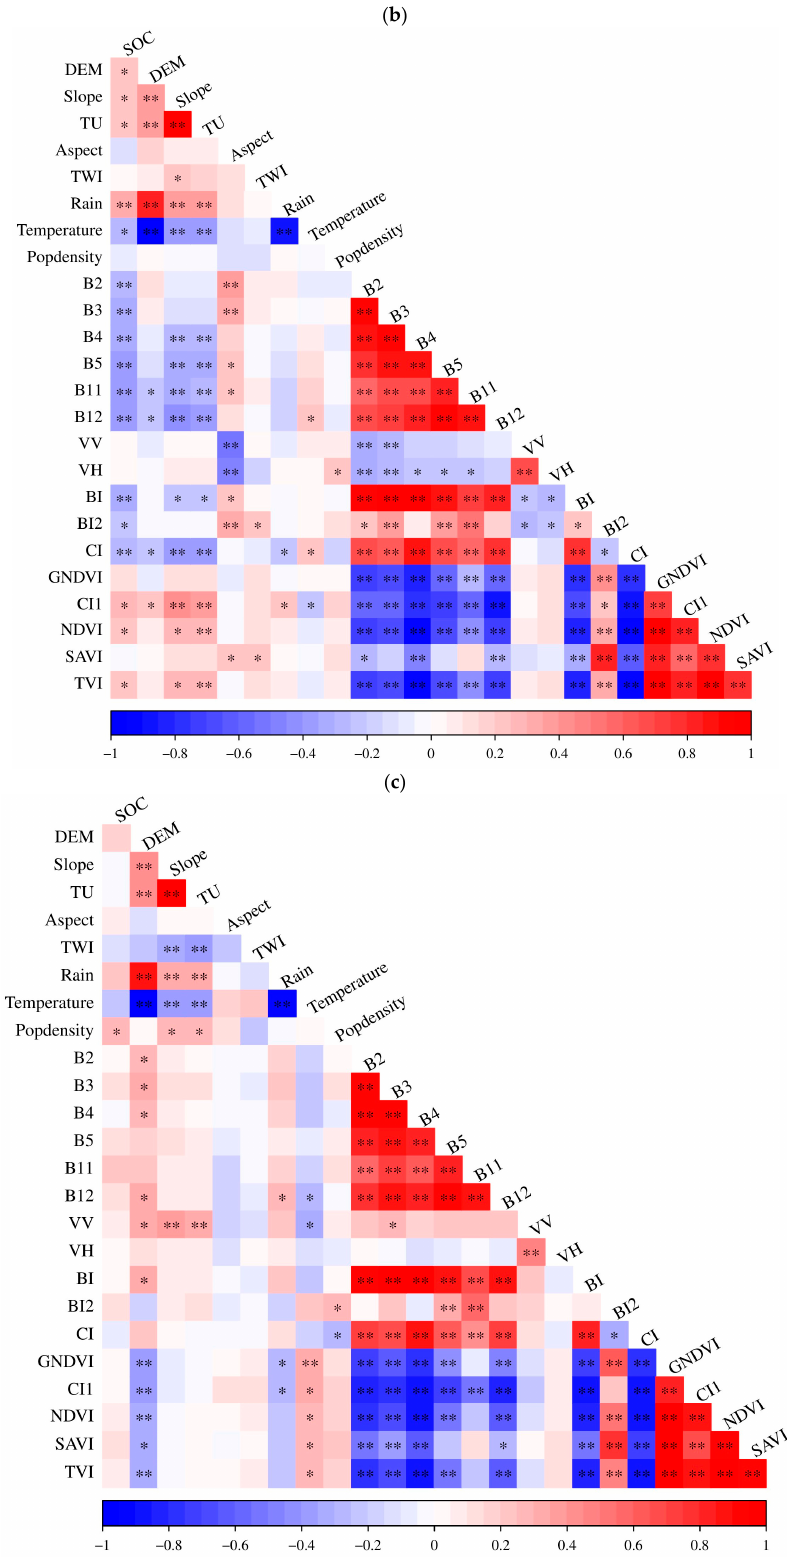
Figure 2. Correlation matrices between SOC and corresponding variables for the overall ( a ), forest ( b ) and farmland areas ( c ). ** correlation is significant at the 0.01 level, * correlation is significant at the 0.05